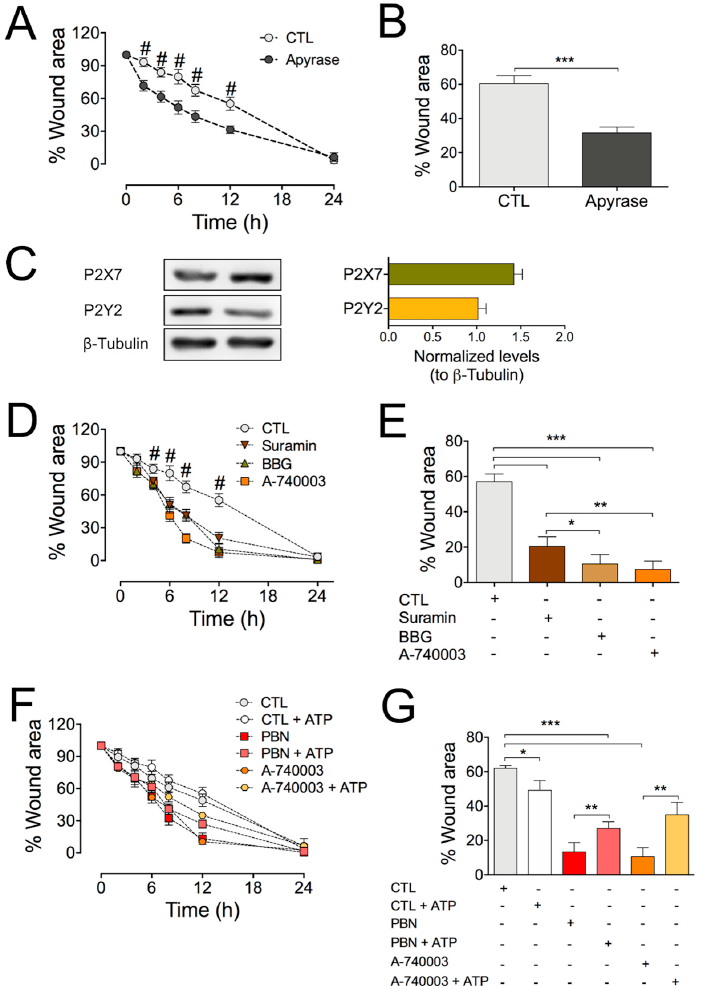
Figure 4. Blockade of the P2X7 receptor accelerates in vitro wound healing in HDF cultures. ( A ) Determination of the effect of exposure to 10 U/mL apyrase on the rate of wound healing assay in HDFs. Comparison between Apyrase and control (CTL); # = *** p < 0.001 for 2, 4, 6, 8, and 12 h; n = 8 (one-way ANOVA followed by Bonferroni’s post hoc test). ( B ) Comparison of the reduction in the wound area induced by respective treatments at 12 h of inducing the wound; *** p < 0.001; n = 8 (unpaired two-tailed t-test). ( C ) Representative Western blot images showing the expression of P2X7R and P2Y2R in two homogenates of HDF cells; β -tubulin was used as a loading control. Graphs depicting the relative amount of P2X7R and P2Y2R normalized to β -Tubulin from 8 different cultures. ( D ) Effects of purinergic receptor antagonists on wound healing assay in HDF cultures. Treatments against control (CTL). # = *** p < 0.001 for 6, 8, and 12 h; n = 10 (one-way ANOVA followed by Bonferroni’s post hoc test). ( E ) Percentage of wound area closure 12 h after inducing wound in HDF cultures treated with different purinergic receptor antagonists. ( F ) Determination of the wound healing rate under sustained application of 1 mM ATP in the absence or presence of PBN or A-740003 in HDFs. ( G ) Effect of exogenous ATP on wound area closure 12 h after inducing wound in absence or presence of PBN or A-740003. * p = 0.0260; ** p = 0.087; *** p < 0.001; n = 8 (one-way ANOVA followed by Bonferroni’s post hoc test). All data are shown as mean ±